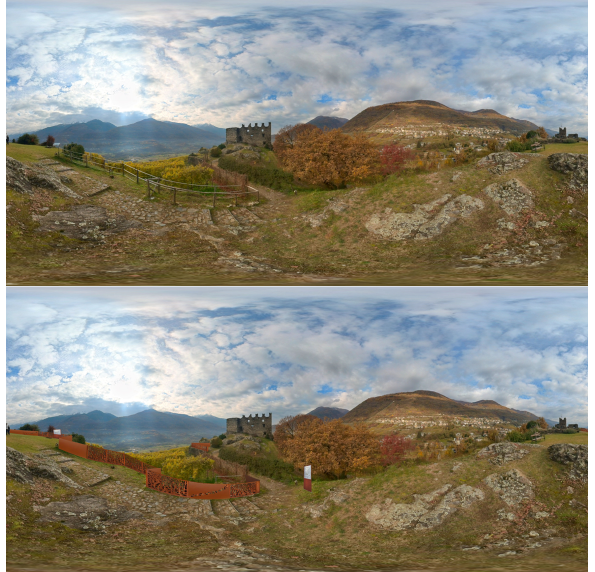
Figure 6: The original equirectangular projection (on top) and the generated rendered projection. As can be seen, straight elements become curved entities in the equirectangular projection.